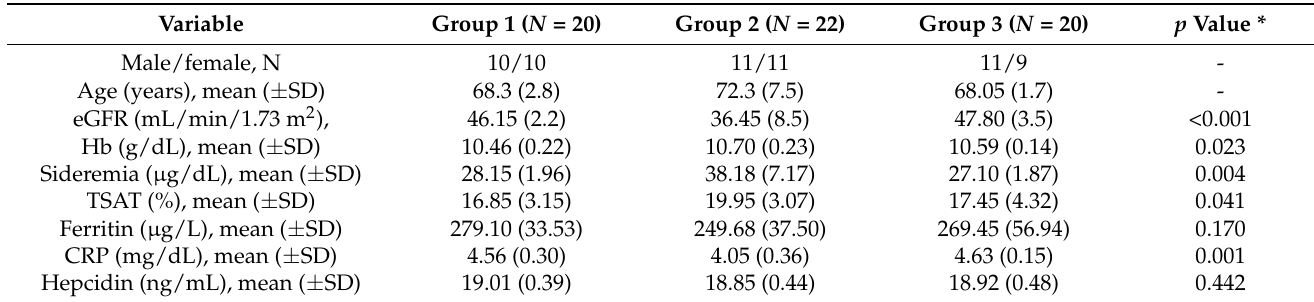
Table 1. Baseline characteristics of Group 1 (treated with ferrous sulfate), Group 2 (treated with ferric sodium EDTA in combination with vitamin C, folic acid, copper gluconate, zinc gluconate, and selenomethionine), and Group 3 (treated with liposomal iron).